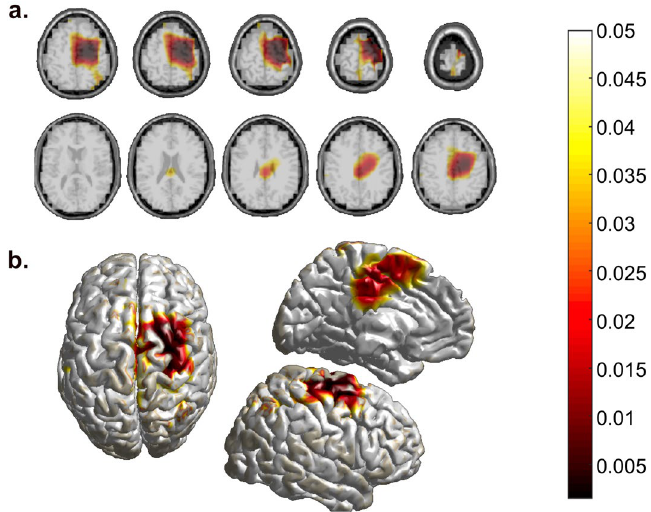
Figure 5. Bonferroni-corrected p -value distribution of Monte Carlo non-parametric permutation statistics on ROT mov and MOT mov source-reconstruction differences in between-blocks ( mov 3 –mov 0) post-movement beta activity increase. ( a ) horizontal slices were obtained by interpolating the statistics onto the MRI template. ( b ) surface plots were obtained by interpolation onto the MNI